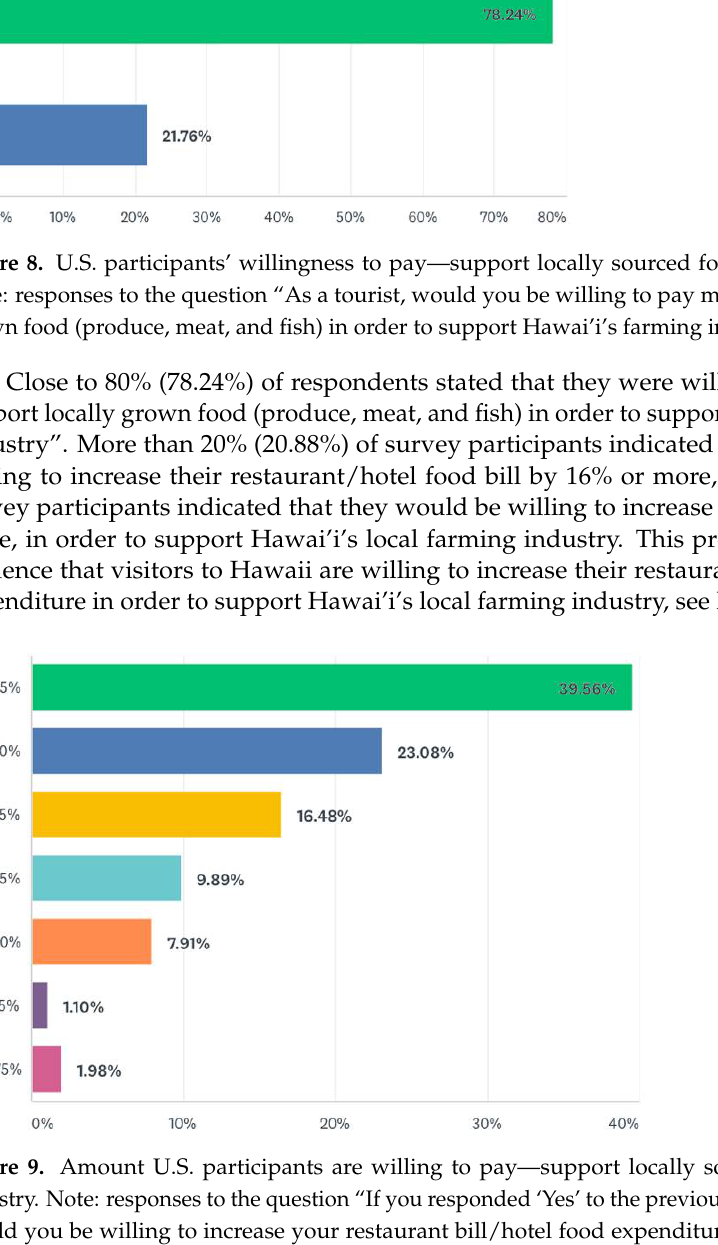
Figure 7. Amount U.S. participants are willing to pay—sustainable tourism. Note: responses to the question “If you responded ‘Yes’ to the previous question, how much would you be willing to in- crease your typical travel expenditure to support sustainable tourism in Hawai’i?”.